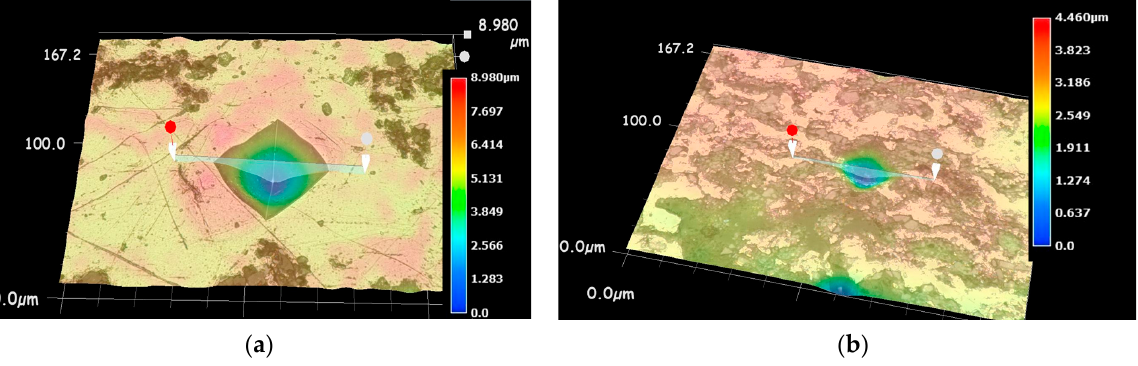
Figure 20. Optical images of indentation footprints of Al + ZrO 2 composites sintered at 550 °C during 1 h: ( a )—Al matrix of Al + 40%ZrO 2 ; ( b )—ZrO 2 particles in Al + 75%ZrO 2 composite. 1 h: ( a )—Al matrix of Al + 40%ZrO 2 ; ( b )—ZrO 2 particles in Al + 75%ZrO 2